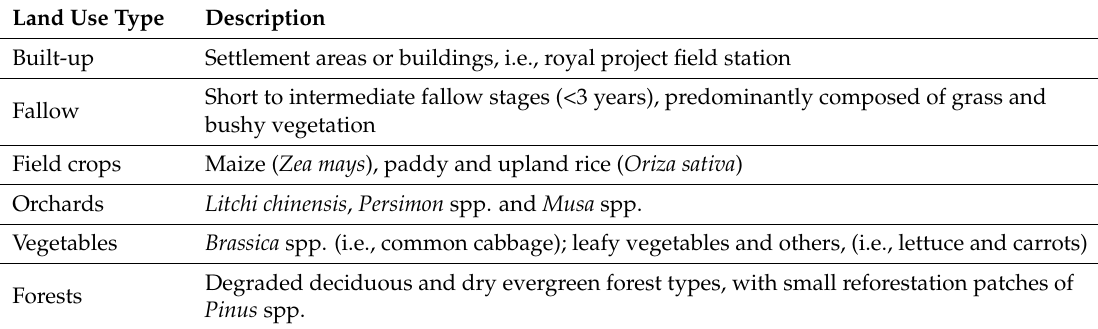
Table 1. Description of land-use types used for land-use change analysis in Mae Sa Mai watershed from 1998 to